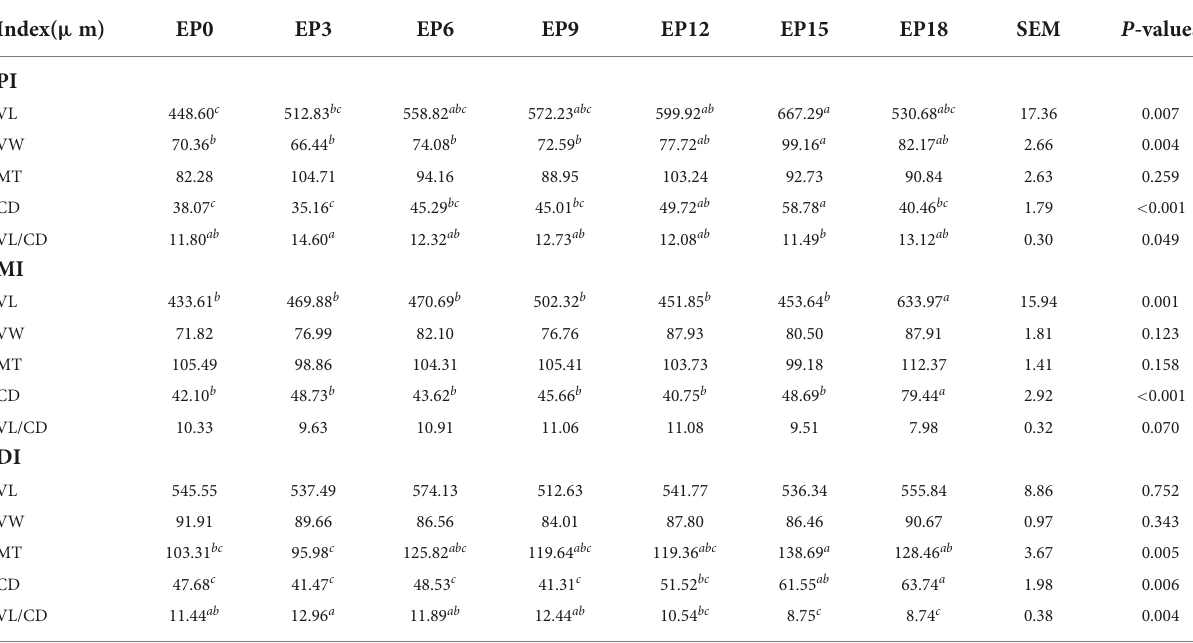
TABLE 6 Intestinal morphology of hybrid groupers fed with